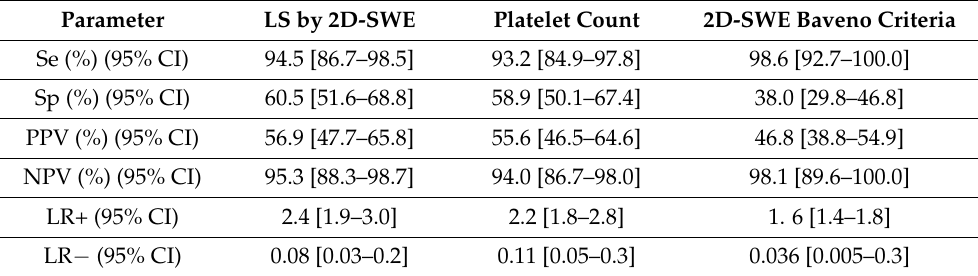
Figure 4. Flow chart of HRV detection. Table 3. Diagnostic performance for each variable in the prediction of